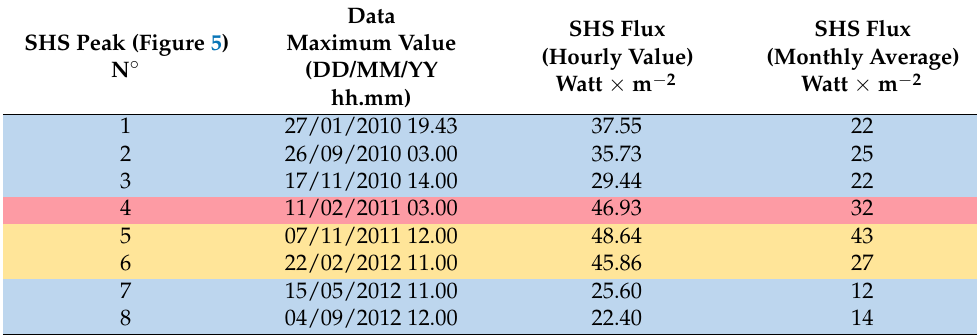
Figure 5. Time variation of the heat flux retrieved from the temperature monitoring of the shallow profile of the ground. The labeled peaks are listed in Table 1; the different colors in the background indicate the same volcanic phases as in Figure 4.